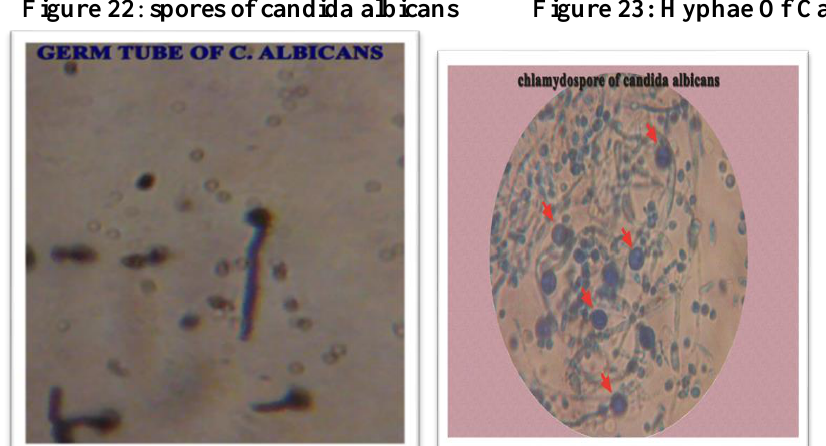
Figure 22 : spores of candida albicans Figure 23: Hyphae Of Candida Albicans